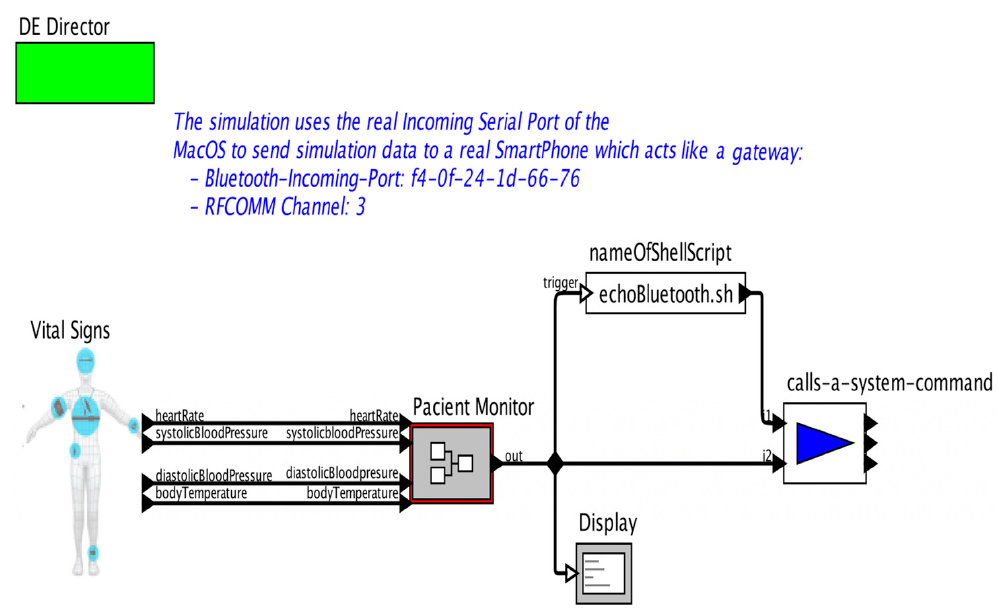
Figure 13. Simulator of the sensing process of the patient’s vital sign data. The simulation data are sent to a real smartphone via Bluetooth.